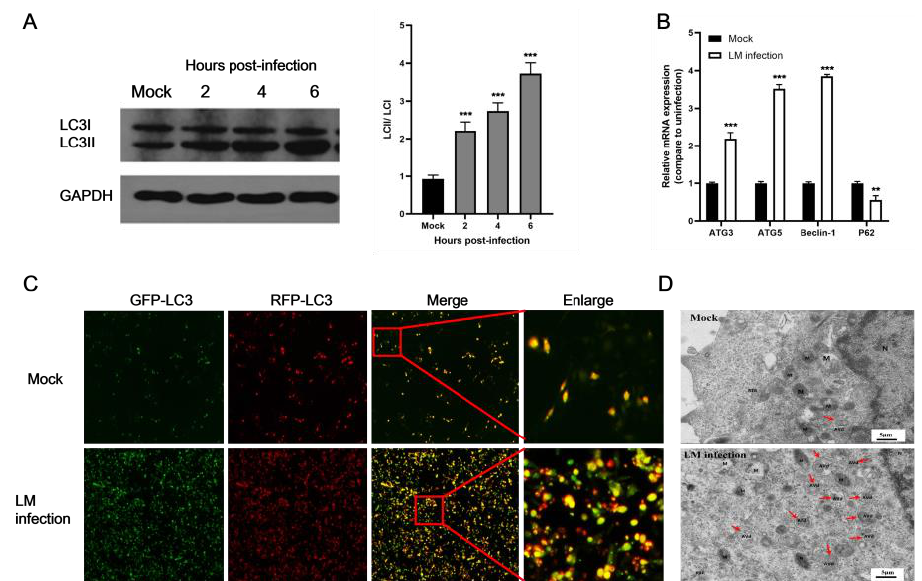
Figure 1. LM induced autophagy in B16F10 murine melanoma cells. ( A ) Autophagy was assessed by Western blotting. B16F10 cells were harvested 0, 2, 4, and 6 h after infection with LM. Expression levels of LC3-I and LC3-II and the conversion of LC3-I to LC3-II were determined by Western blotting. Protein expression ratios of LC3-II/LC3-I were analyzed by GraphPad Prism 5.0. Data are presented as the means ± SD. ( B ) Quantification of autophagy gene mRNA levels was detected by real-time quantitative PCR. B16F10 cells were harvested at 4 h after infection with LM. The level of autophagy was analyzed by detecting the relative expression levels of Atg3, Atg5, Beclin-l, and p62. Results represent the means ± SD from three independent experiments. ( C ) B16F10 cells were infected with adenovirus with mRFP-GFP-LC3. After 2 h, cells were treated with LM for 1 h and autophagic flux was detected with an inverted fluorescence microscope. Representative images of the fluorescent LC3 puncta are shown. Yellow puncta represent phagophores and autophagosomes, and red puncta represent autolysosomes, Merge ( × 40); enlarge ( × 100). ( D ) Ultrastructural analysis by TEM indicated that LM infection induced autophagosome accumulation in B16F10 cells. Red arrows indicate degrading autophagosomes (Avd). M, mitochondria; RER, rough endoplasmic reticulum; N, nucleus. Scale bars, 5 µ m (** p < 0.01, *** p <